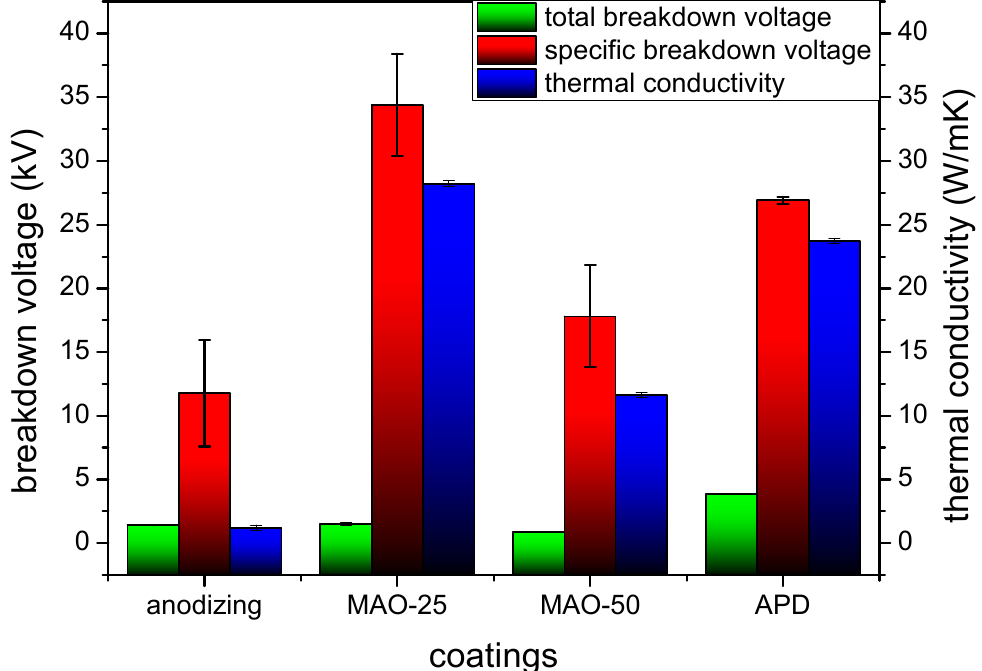
Figure 10. The breakdown voltage and thermal conductivity of anodizing, MAO and APD coatings.